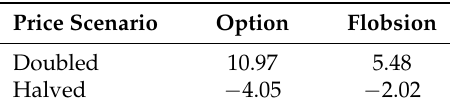
Table 1. Expected deviations from zero-expected profit (loss) in Euro/tCO 2 in case of an option and a flobsion. Positive numbers are profits, negative numbers are losses.